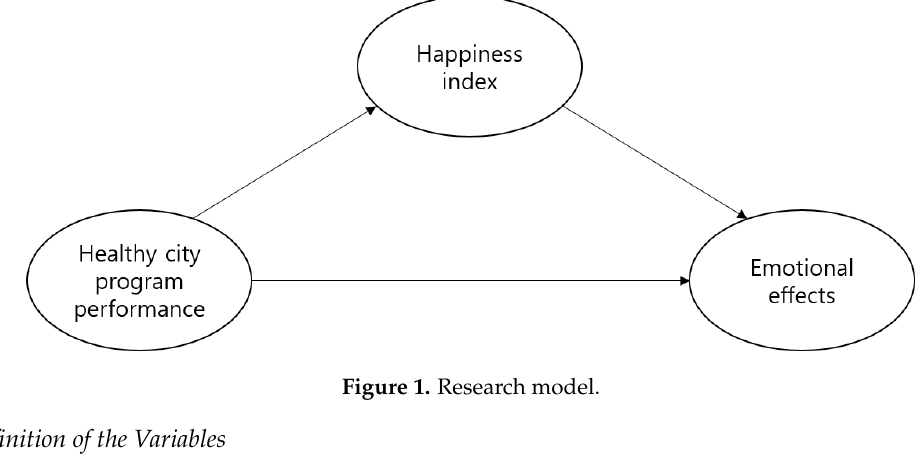
Figure 1. Research model.